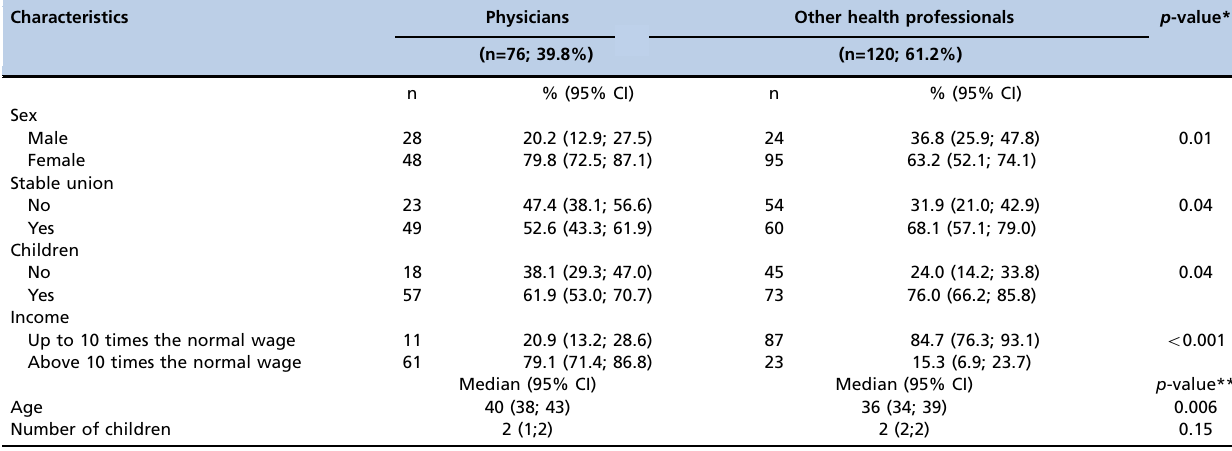
Table 1 - Socioeconomic characteristics of the physicians and other health professionals interviewed in the Health Care System for Women and Children (SASMC) in the state of Acre, Brazil, in 2017. Characteristics